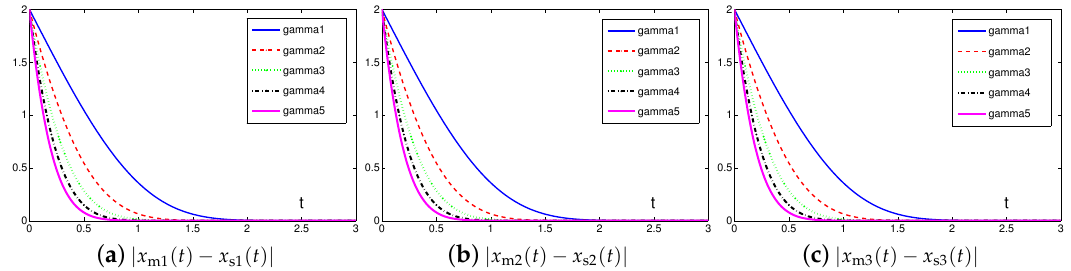
Figure 13. Absolute errors between two identical Lu chaotic systems (24) and (25) equipped with controller (6) via the proposed SEZN approach using different values of design parameter λ .